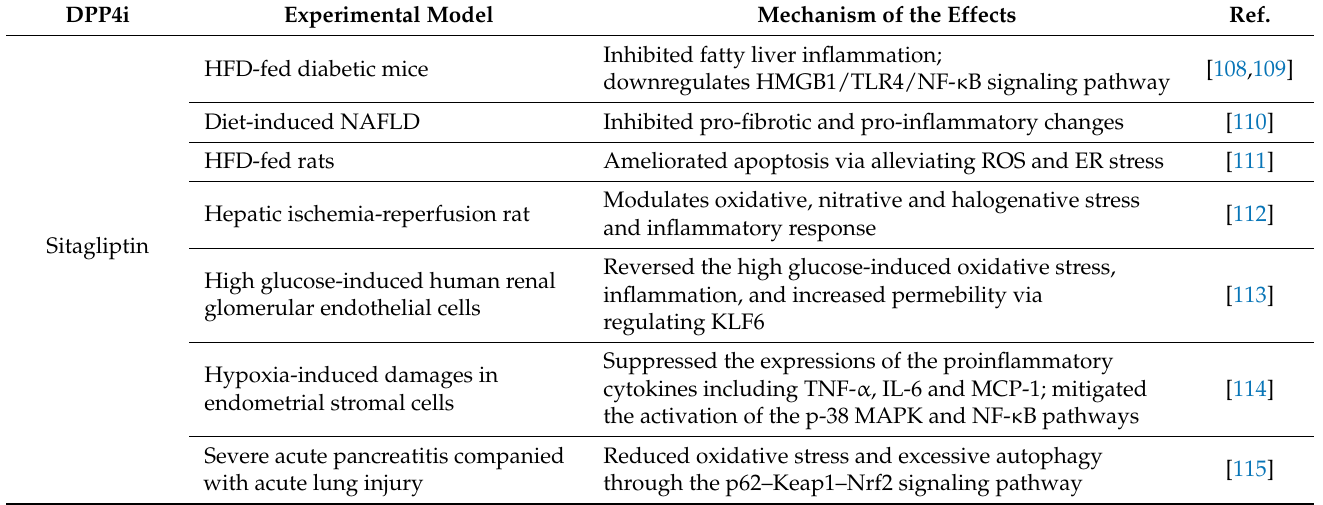
Table 4. The anti-inflammatory effects of DPP4